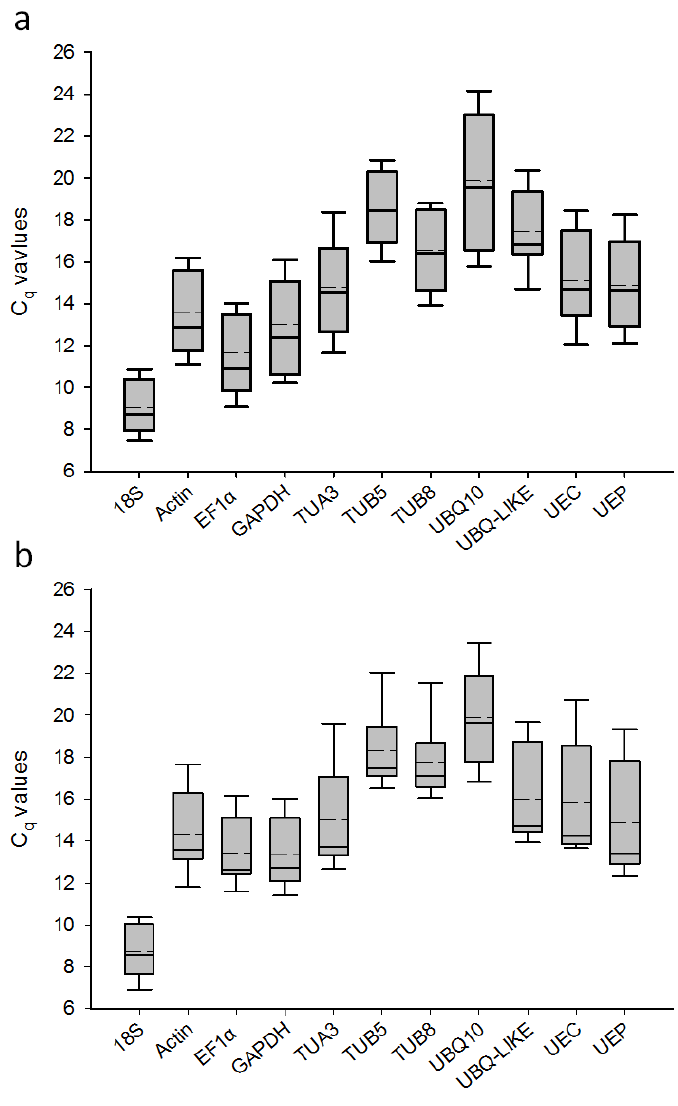
Figure 1. C values of the 11 candidate reference genes in the RT-qPCR analysis q ( a ) Eleven samples at two developmental stages; ( b ) Nine samples exposed to desiccation and cold stress treatments. The Cq values are shown as the first and third quartile. The vertical lines indicate the range of values. The median values are indicated by solid lines, and the mean values are indicated by broken